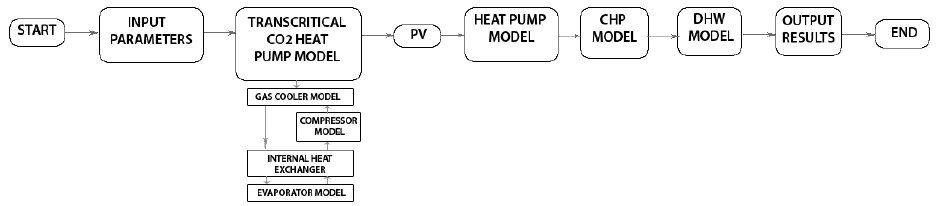
Figure 1. Flowchart for the hybrid energy system model.